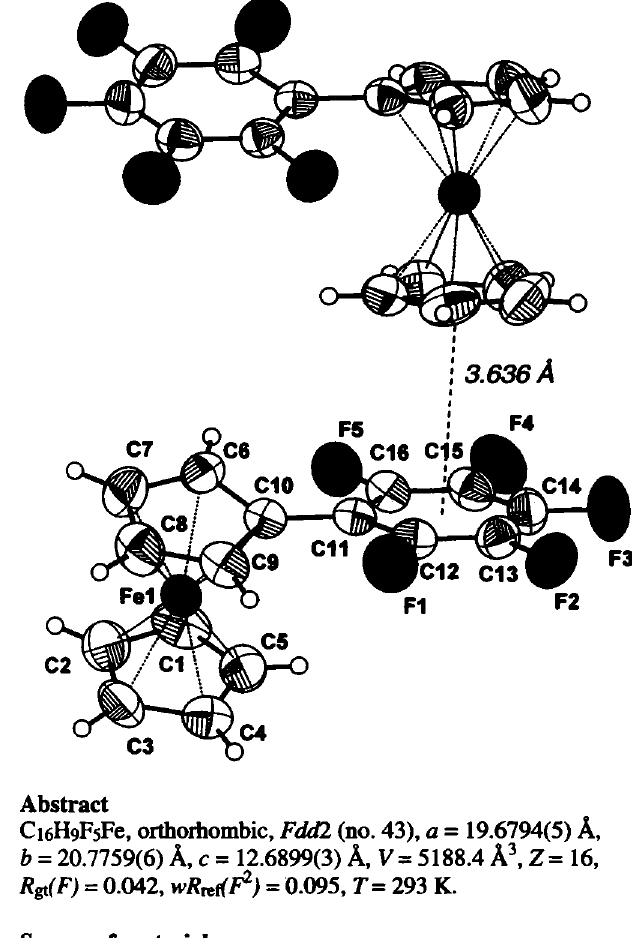
Table 1. Data collection and